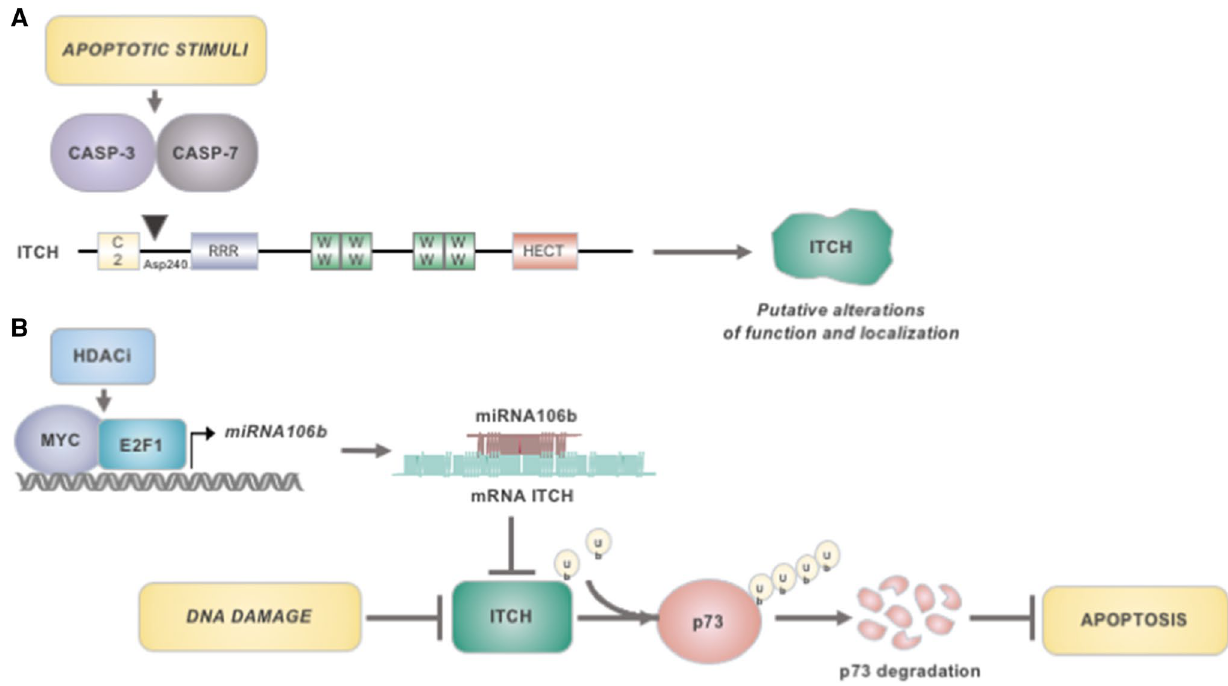
Fig. 4 Implications of ITCH in apoptotic cell death of CLL cells. A Upon apoptotic stimuli , Caspase-3 and Caspase-7-mediated cleavage of ITCH on Asp240 residue may affect its function and localization by releasing an N-terminal fragment that contains the JNK1 regulatory domain and the C2 domain, respectively. B Both DNA damage (e.g. chemotherapeutic drugs) and HDAC inhibitors promote ITCH down- regulation. HDAC inhibition activates E2F1- and Myc-mediated transcription of miR106b, promotes ITCH downregulation. ITCH reduces p73 levels by targeting it for poly-ubiquitination and proteasomal degradation, thus inhibiting